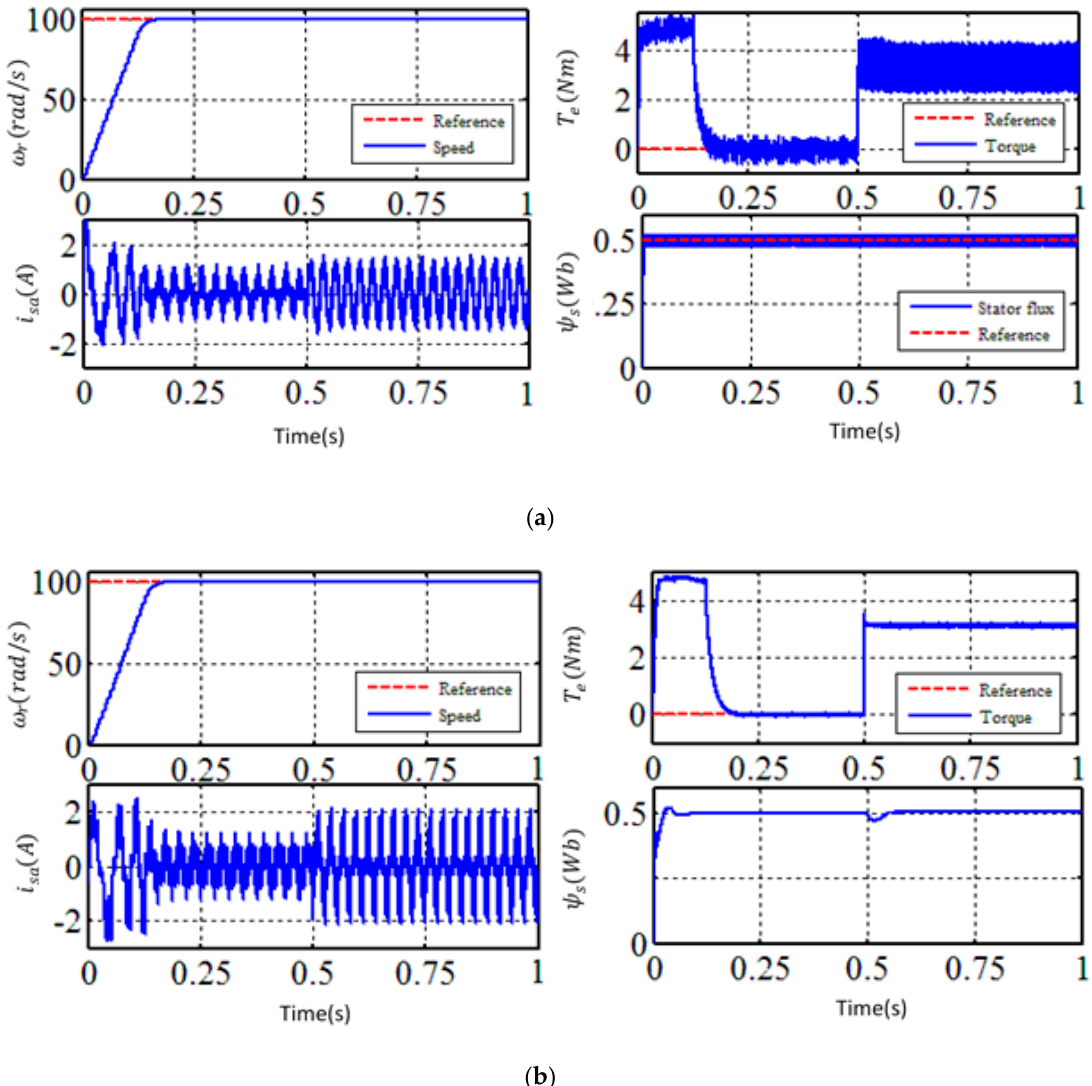
Figure 7. Load change condition of the 6PIM controlled by the duty cycle control strategy ( a ) and proposed method ( b ).